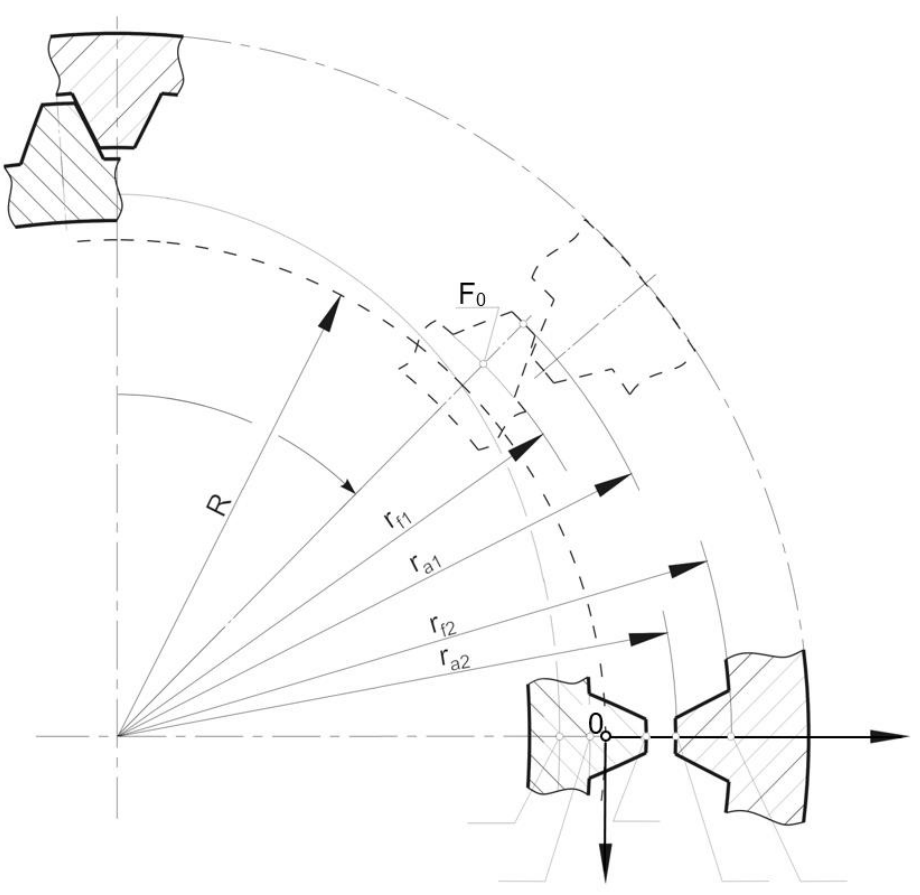
Figure 5. Position of teeth in moment t = 0: y , z —the coordinate system in which the relative movement of the tooth is considered, R—radius of the neutral layer of not deformed flexspline, r a 1 , r a 2 —tip radii, r f 1 , r f 2 —root radii.